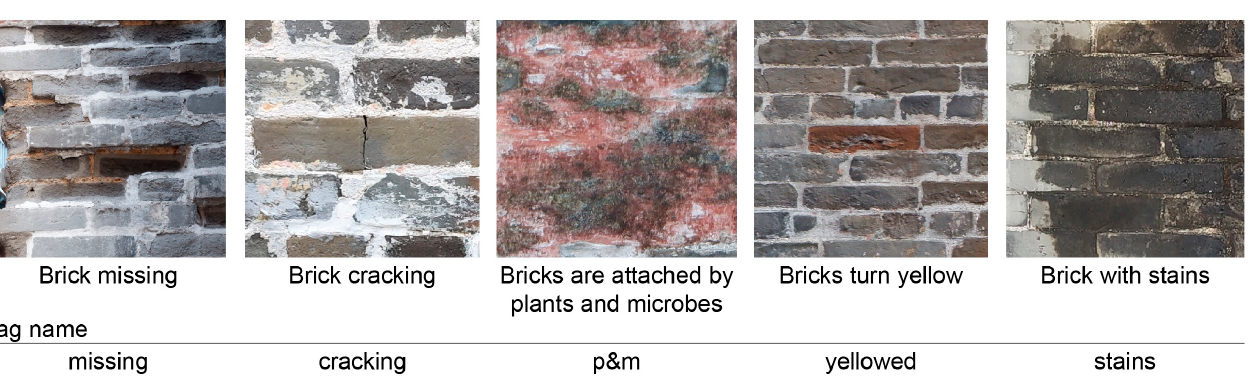
Table 1. The relationship between the types of damage to gray bricks and climate factors.